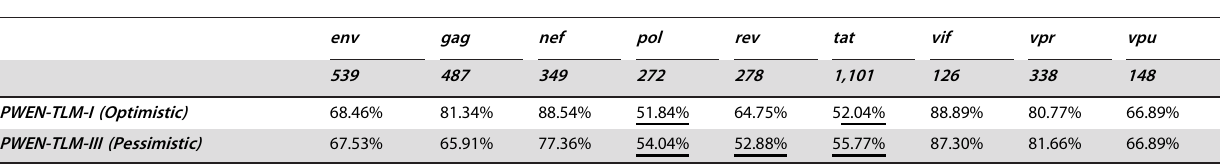
Table 3. Independent test performance estimation.